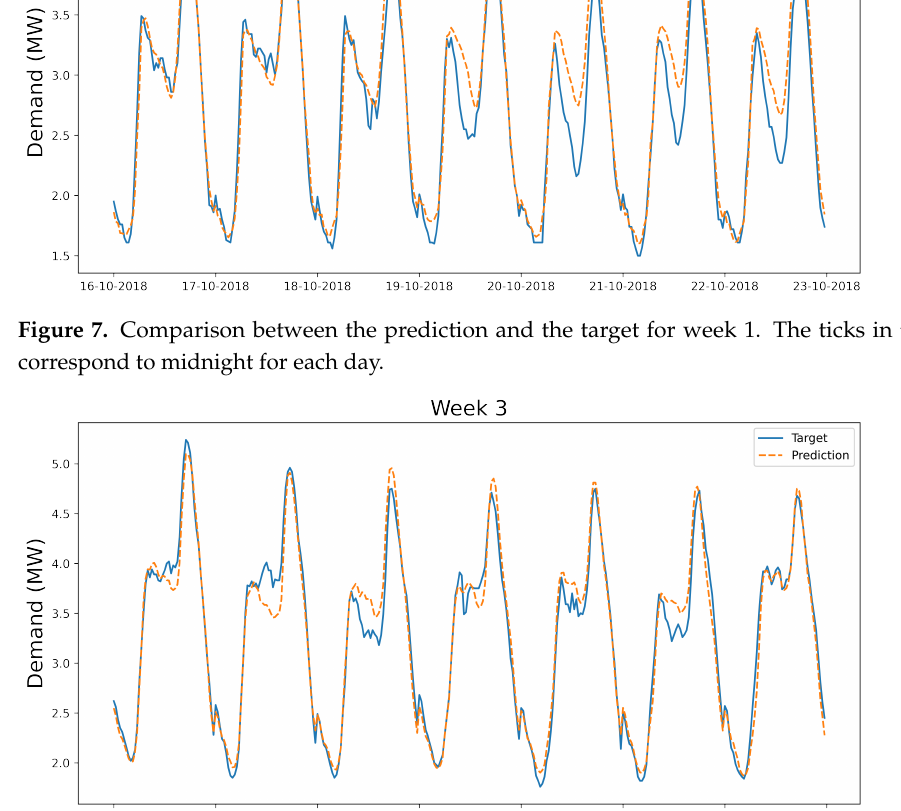
Figure 8. Comparison between the prediction and the target for week 3. The special treatment for holidays leads to an accurate demand prediction for Christmas